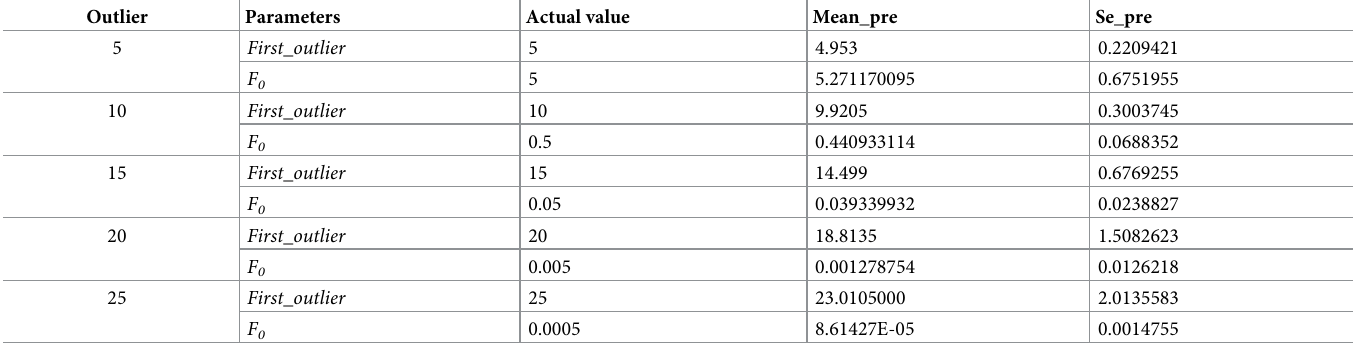
Table 1. The means and variances for estimation of different parameters in 2000